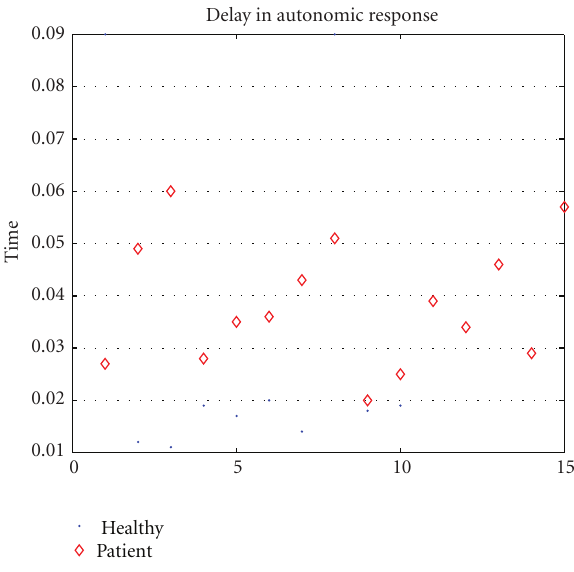
Figure 5: Delay in autonomic